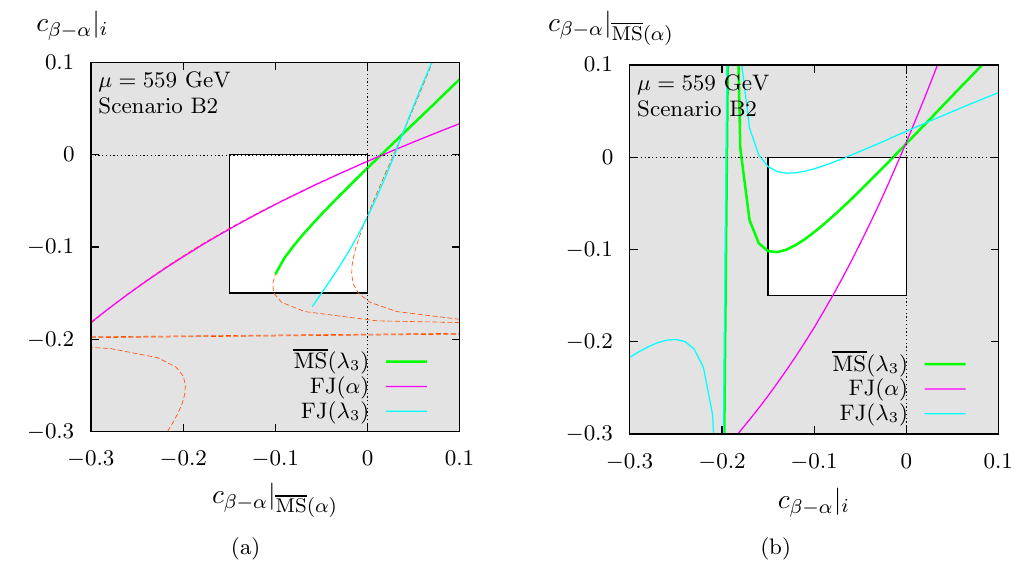
Figure 27 . Panel (a): conversion of the value of c (cid:12) (cid:0) (cid:11) from MS( (cid:11) ) to the other renormalization schemes for scenario B2 with the colour coding of (cid:12)gure 8. Panel (b) shows the conversion to the MS( (cid:11) ) scheme with the same colour coding. The solid lines are obtained by solving the implicit equations numerically, the dashed orange lines correspond to the solution of (b) mirrored at the diagonal. The linear approximation does not provide reasonable results. The highlighted region shows the phenomenologically most relevant c (cid:12) (cid:0) (cid:11) region. (e.g. (cid:21) 1 ) or a combination (e.g. (cid:21) 1 + (cid:21) 2 ) as independent parameter renormalized in